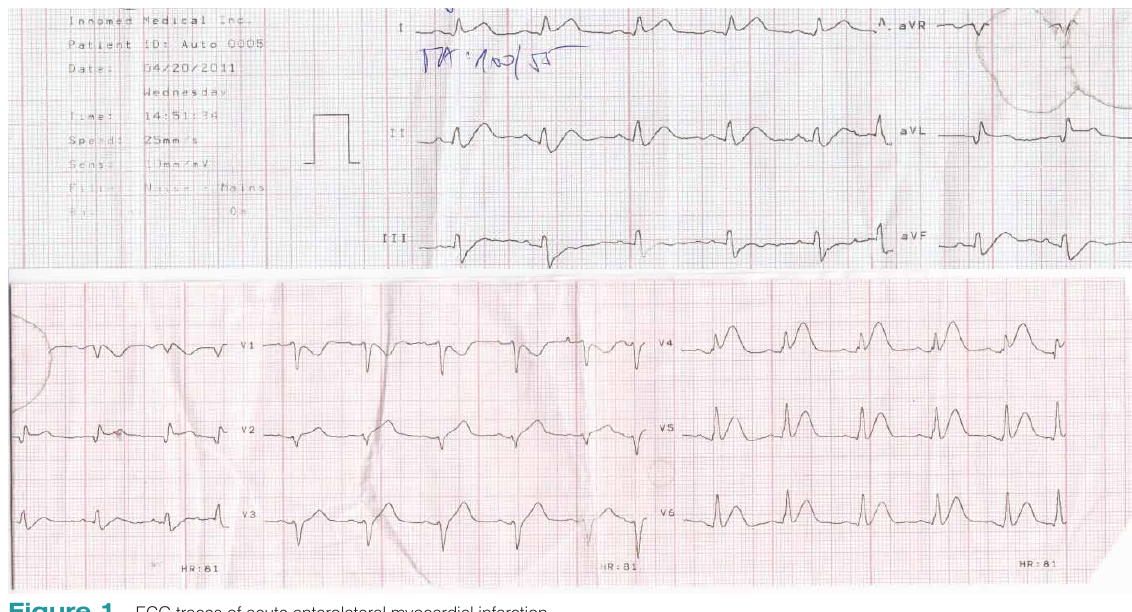
Figure 1. ECG traces of acute anterolateral myocardial infarction.